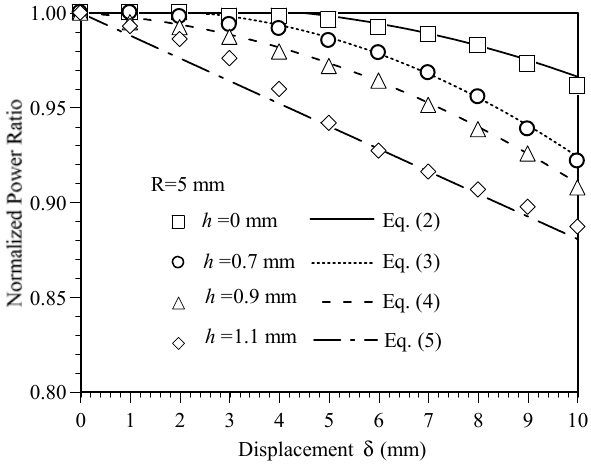
Figure 6. Variation of normalized power ratio (cid:2015)(cid:1191) with displacement as function of groove depth h .